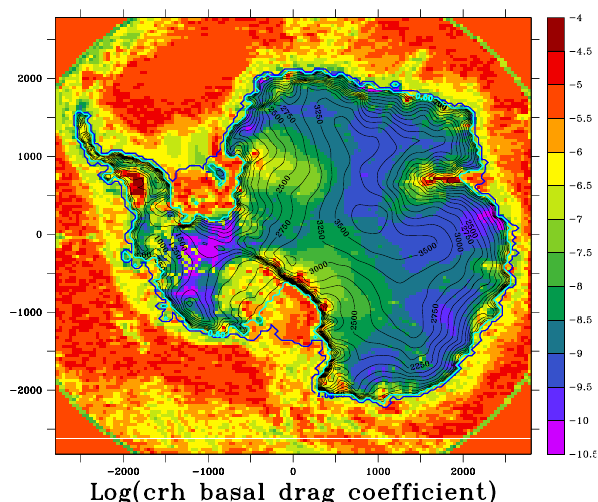
Fig. 1. Basal sliding coefficient for baseline parameter vector nn2679 and associated surface elevation contours. Note value re- ductions due to cold basal conditions have not been applied to the plotted field. The logarithms of slidhardC and slidsedC have re- spective values − 8.5886 and −